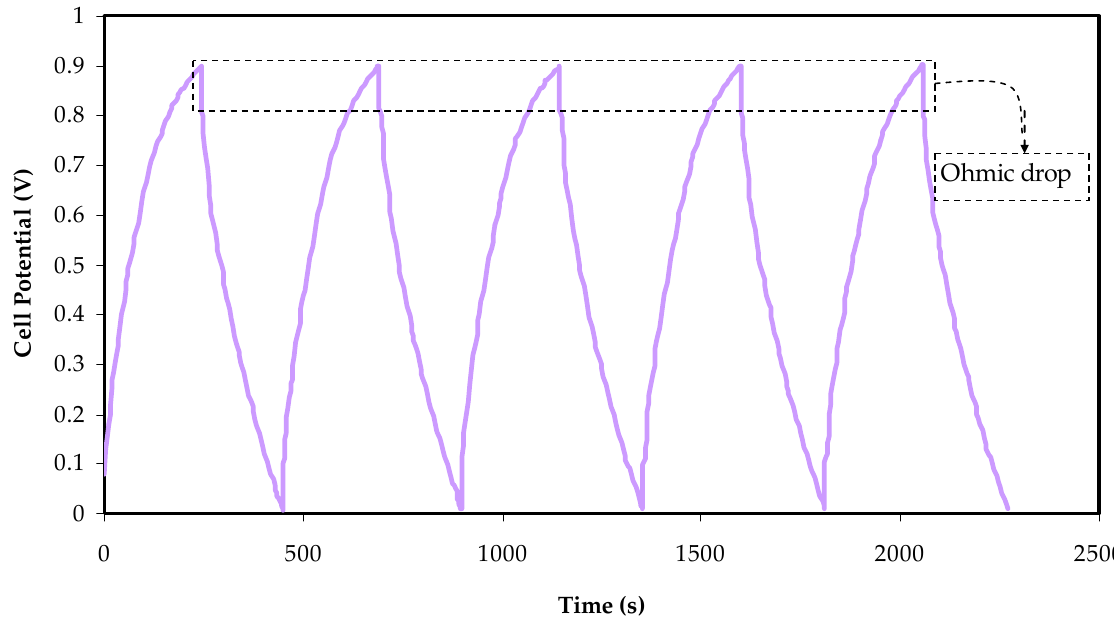
Figure 8. The charge–discharge plot of the fabricated EDLC at 0.5 mA cm − 2 in the potential range of 0 to 1 V.